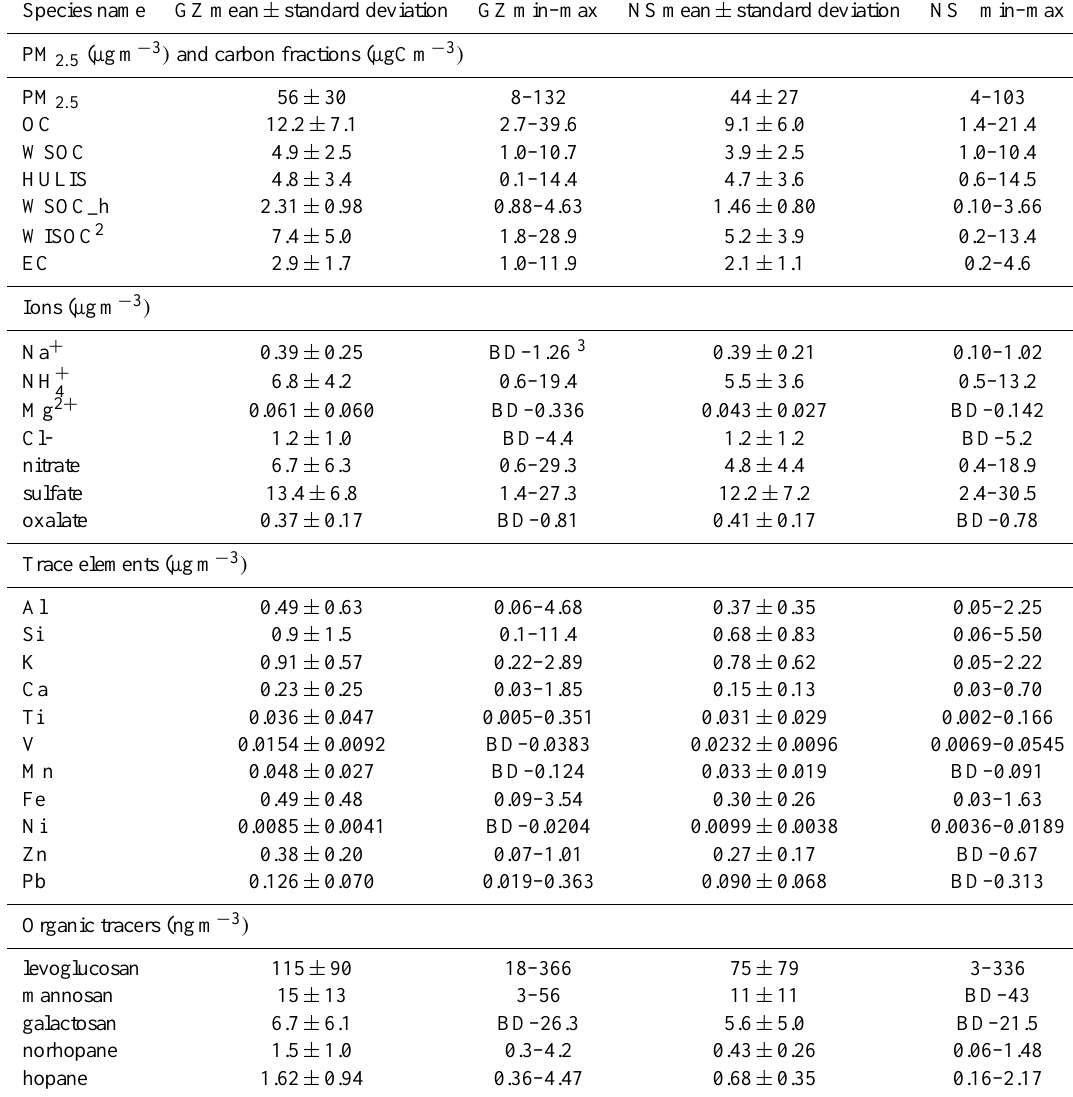
Table 1. Statistic summary for the ambient concentrations of major aerosol constituents, HULIS, elements and organic tracer compounds used in the PMF